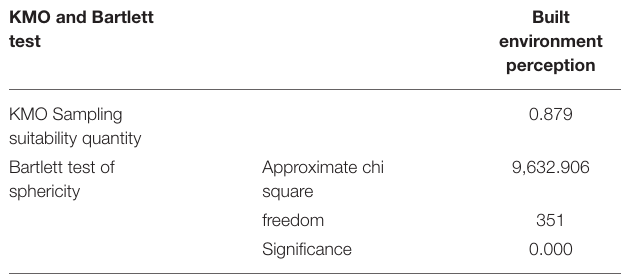
TABLE 5 | KMO and Bartlett’s test